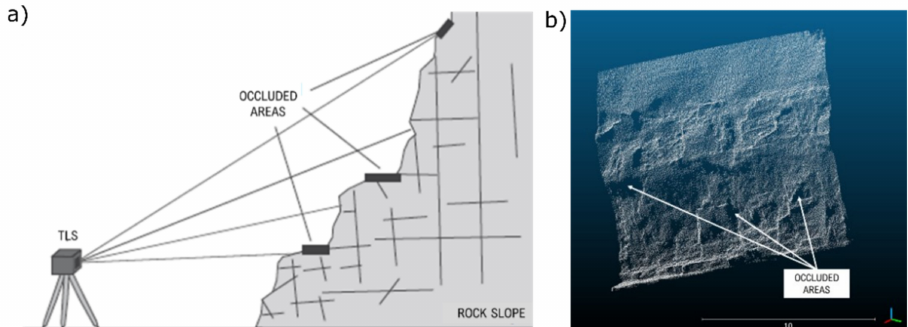
Figure 14. Orientation bias (Terzaghi bias) for clusters j2 and j4 which strikes sub-parallel to the mean orientation of the slope (( a ). sketch of occlusion problems, ( b ). portion of the raw point cloud showing the occluded